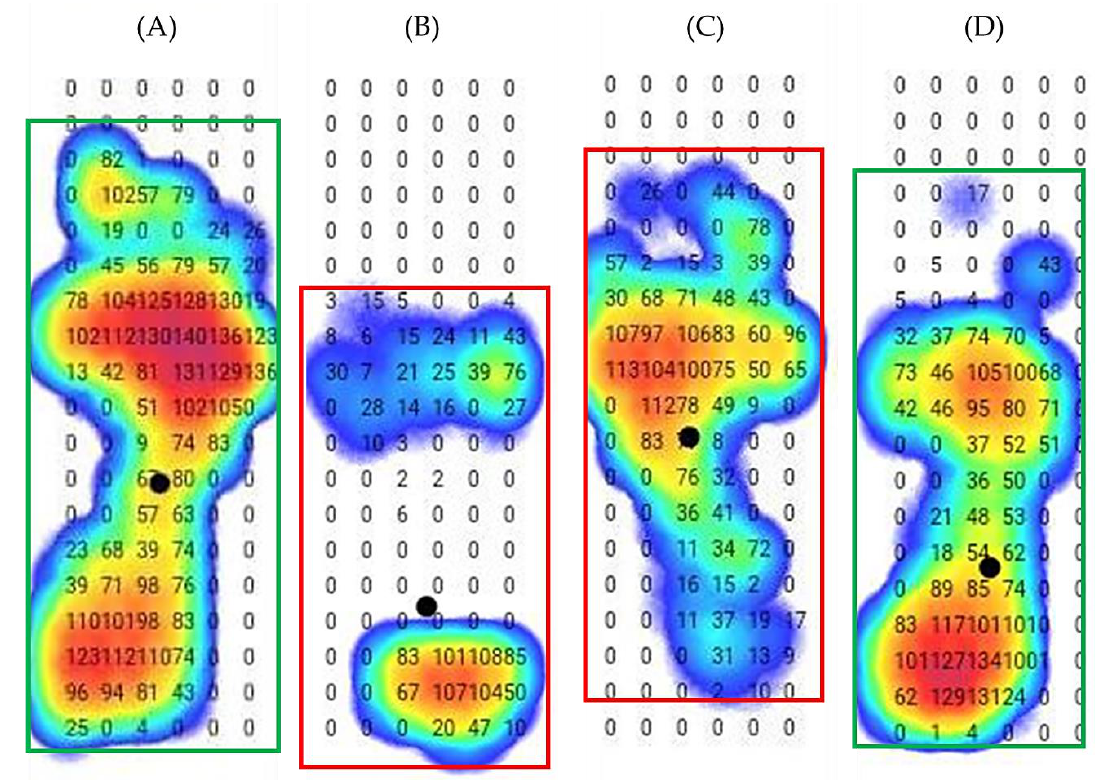
Figure 4. The examples of labeling the maximum area of plantar pressure image dataset with a different condition; ( A ) The footprint images with pressure in the full foot. ( B ) Complex footprint images with pressure in the rearfoot and midfoot but loss of pressure in the forefoot. ( C ) The abnormal foot progression angle with high pressure on the forefoot and midfoot and less pressure on the rearfoot. ( D ) Defective footprint images with high pressure on the heels, lost pressure on the midfoot and forefoot.